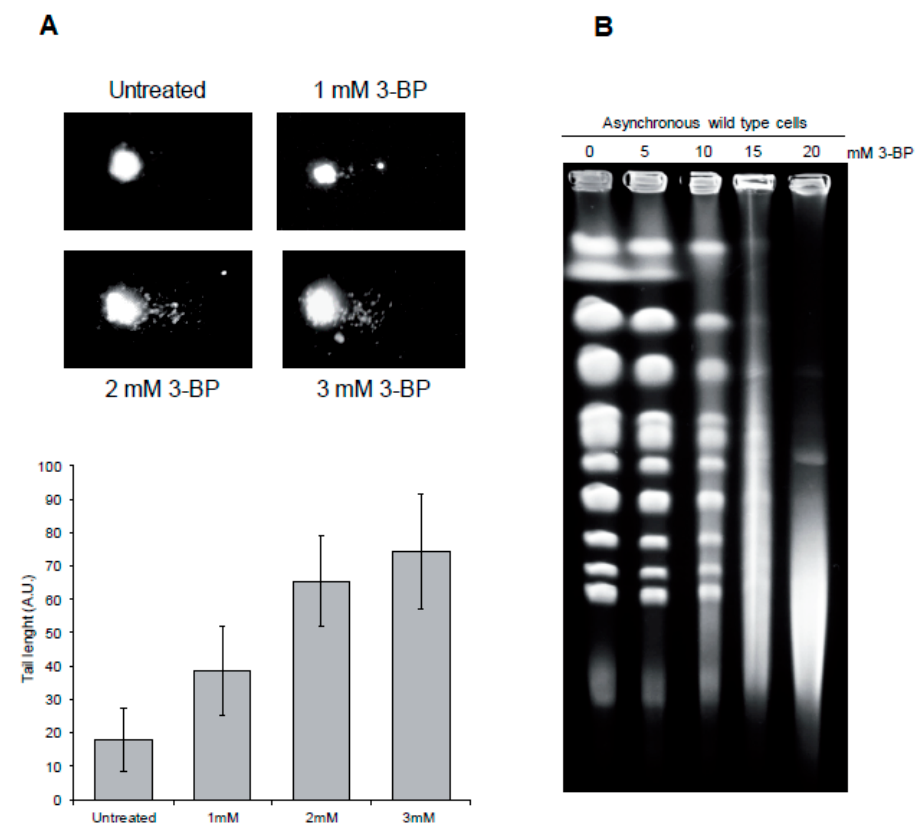
Figure 6. 3-BP treatment leads to DNA double-strand break formation in yeast: ( A ) 3-BP induces DNA breakage in yeast as revealed by the comet assay. Asynchronous wild type cells were exposed to indicated 3-BP concentrations for 2 h or left untreated followed by a single-cell gel electrophoresis. Representative images of comets are shown. Error bars represent mean value ± standard deviations of mean ( n = 3). ( B ) Exposure to 3-BP results in generation of DNA double-strand breaks. A logarithmically growing culture of wild type cells was treated with indicated concentrations of 3-BP for 5 h. Next, intact chromosomes were isolated and processed for pulsed-field gel electrophoresis (PFGE).